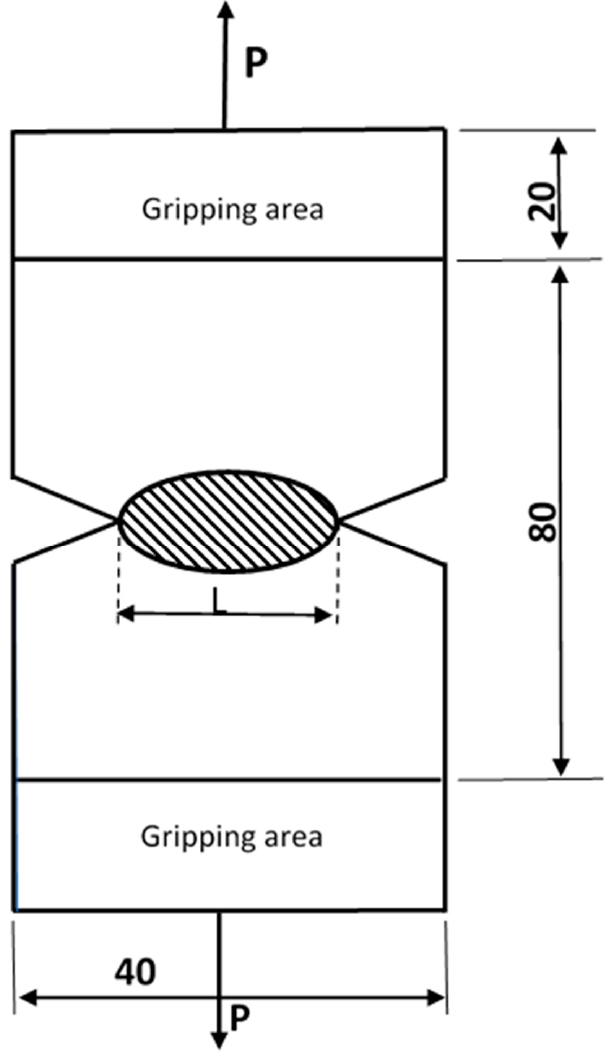
Figure 1. Double edge notch tension (DENT).